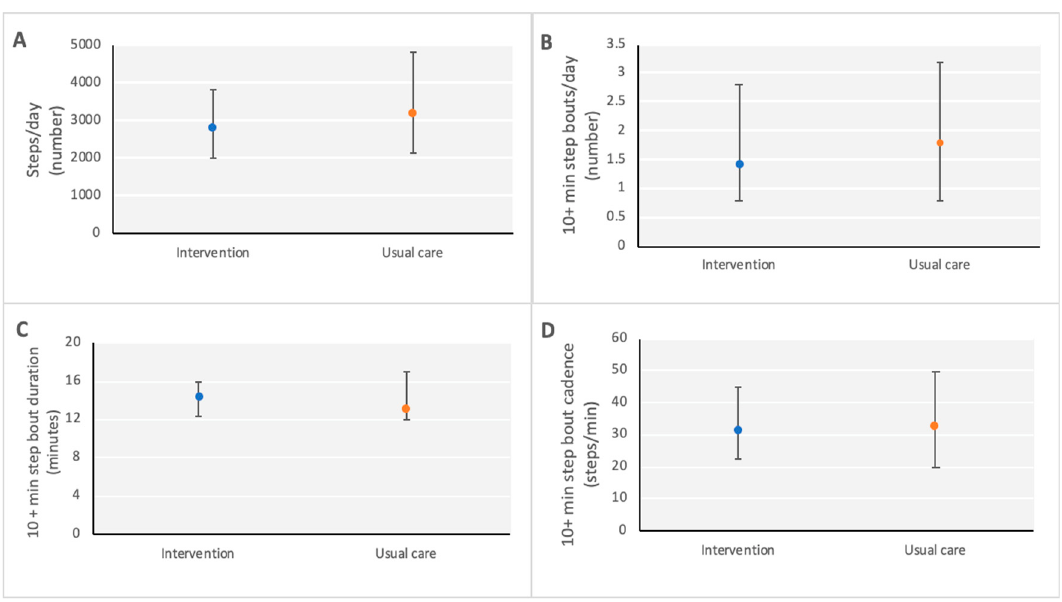
Figure 2. Baseline PA levels: ( A ) Steps per day (number); ( B ) 10 + min step bouts (number of bouts per day); ( C ) 10 + min step bout duration (minutes); ( D ) 10 + min step bout cadence (steps per minute). Values are median (interquartile range).